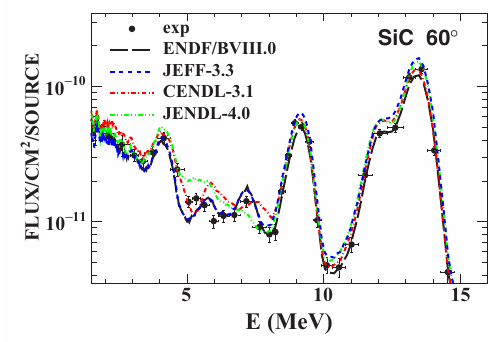
Figure 6. Neutron leakage spectra for SiC sample at 60 ◦ .